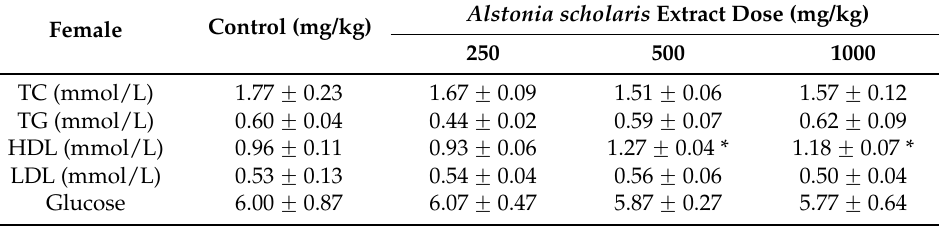
Table 7. Effect of 28 days of oral administration of the methanolic extract of the bark of Alstonia scholaris on plasma glucose levels and lipid profiles in female rats. Results were expressed as the mean ˘ S.E.M. of 5